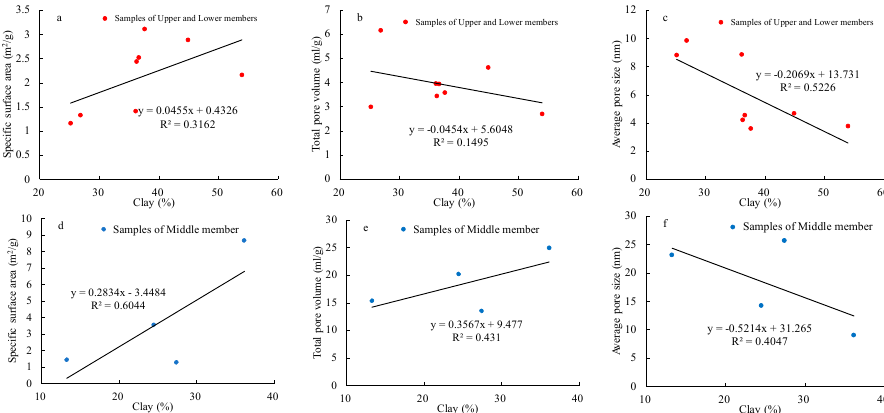
Figure 8. The relationship between pore structure parameters and clay content. ( a ) Specific surface area vs. clay content for Upper/Lower Bakken samples; ( b ) Total pore volume vs. clay content for Upper/Lower Bakken samples; ( c ) Average pore size vs. clay content for Upper/Lower Bakken samples; ( d ) Specific surface area vs. clay content for Middle Bakken samples; ( e ) Total pore volume vs. clay content for Middle Bakken samples; ( f ) Average pore size vs. clay content for Middle Bakken